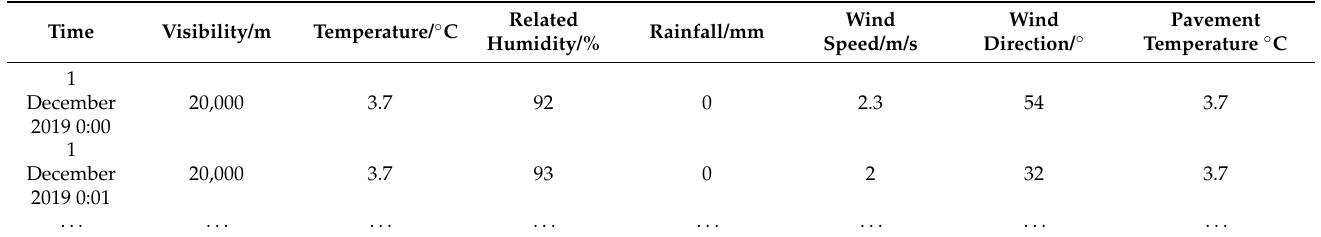
Table 1. The raw data format of VAISALA road weather station.